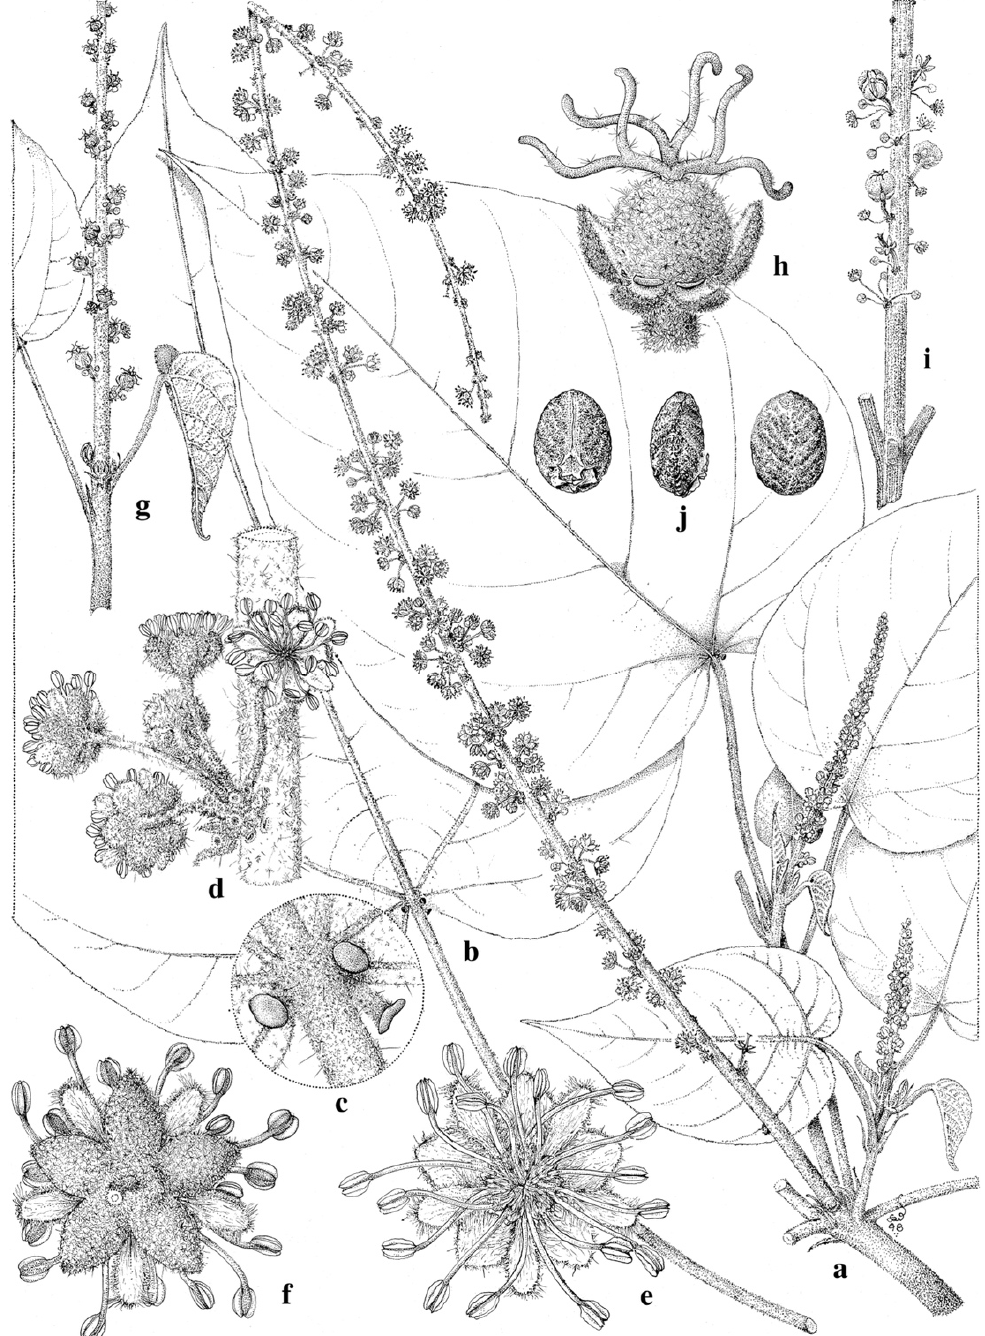
Figure A18. Croton draco ( a ) Flowering branch. ( b ) Leaf base. ( c ) Close-up of extrafloral nectaries at the base of the leaf blade. ( d ) Staminate cymule. ( e ) Staminate flower from above. ( f ) Staminate flower from below. ( g , i ) Inflorescences. ( h ) Pistillate flower with two sepals removed. ( j ) Seed, ventral (left), lateral (center), and dorsal (right) views. Illustrated by Karen Douthit for Flora Novo-Galiciana. ©The University of Michigan Herbarium (MICH) and used here with their